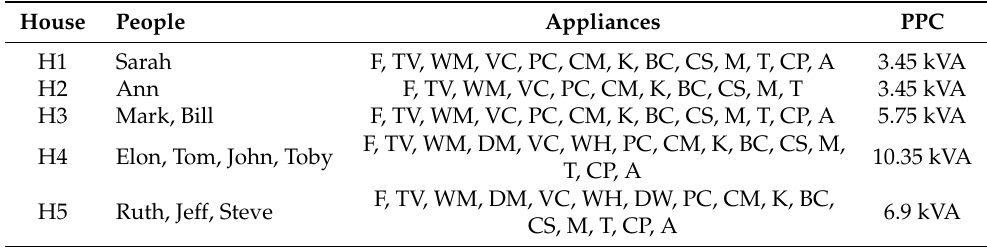
Table 1. Characteristics of the generated